Question: What does this figure show? Answer in one sentence.
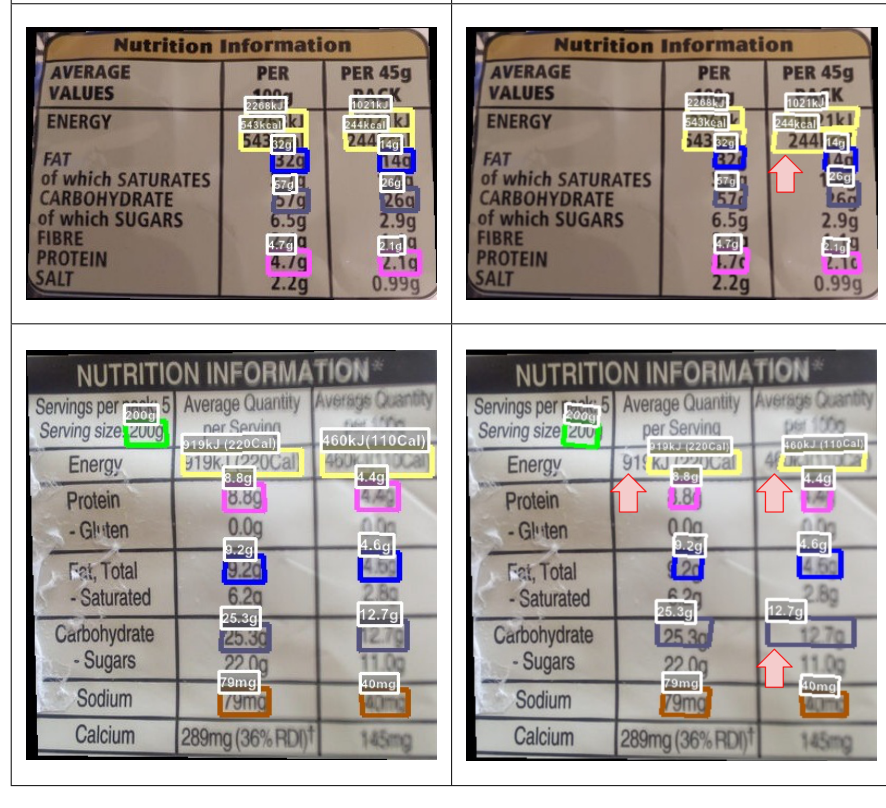
Answer: Comparison of Cases of Supervised and Weakly-Supervised Learning. Both approaches successfully capture the center points of the text. However, there was a difference in how accurately the model extracted the boundaries of the text boxes.